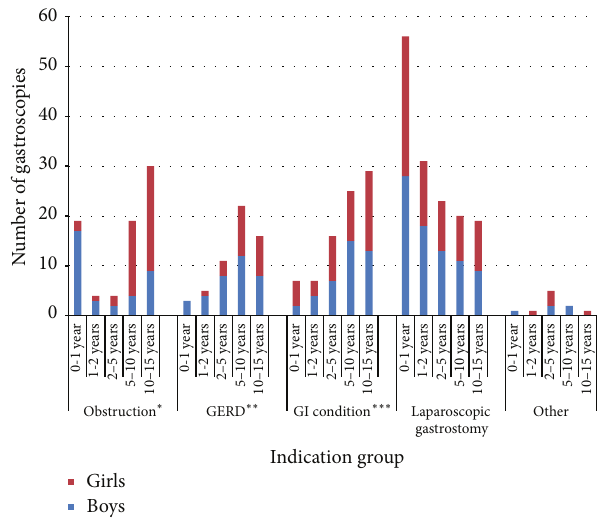
Figure 4: Age distribution among indication groups for all 376 patients from 0 to 15 years of age from July 2011 to May 2014. ∗ Obstruction in the upper gastrointestinal tract, ∗∗ gastroesophageal reflux disease, and ∗∗∗ investigation of gastroenterological condi- tions.